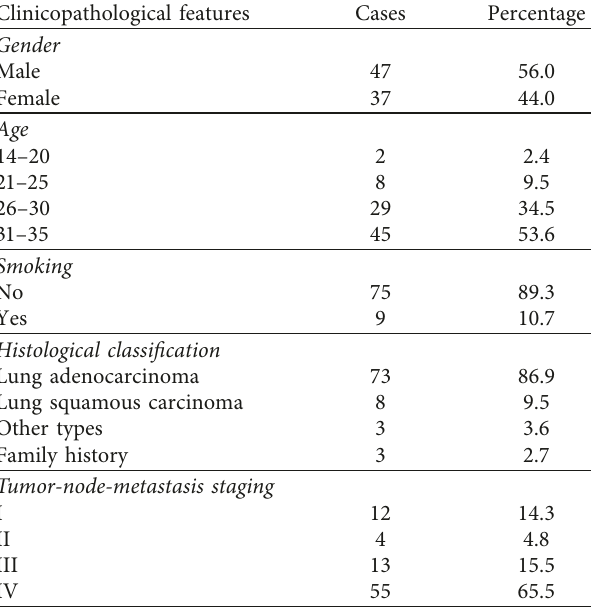
Table 1: Clinicopathological features of young patients with NSCLC in the study ( N � 84